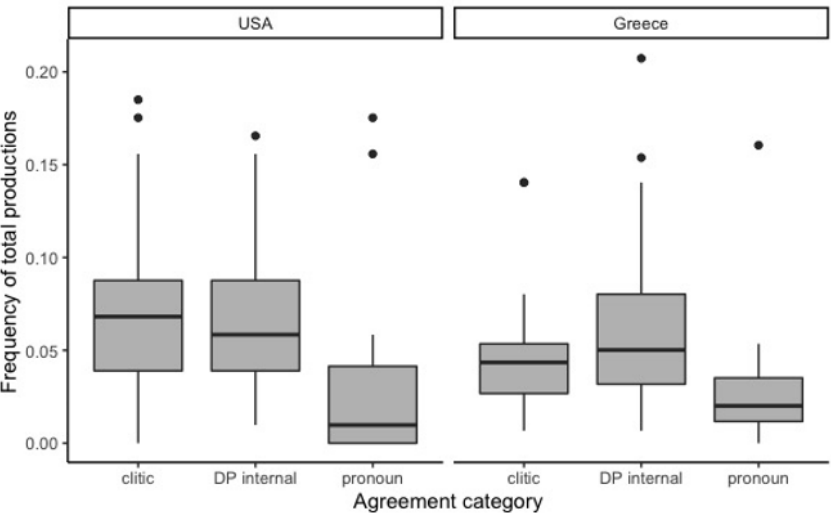
Figure 4. Normalized frequency of total productions for each agreement category (clitic, DP internal, pronoun) per country (USA, Greece) within the adults’